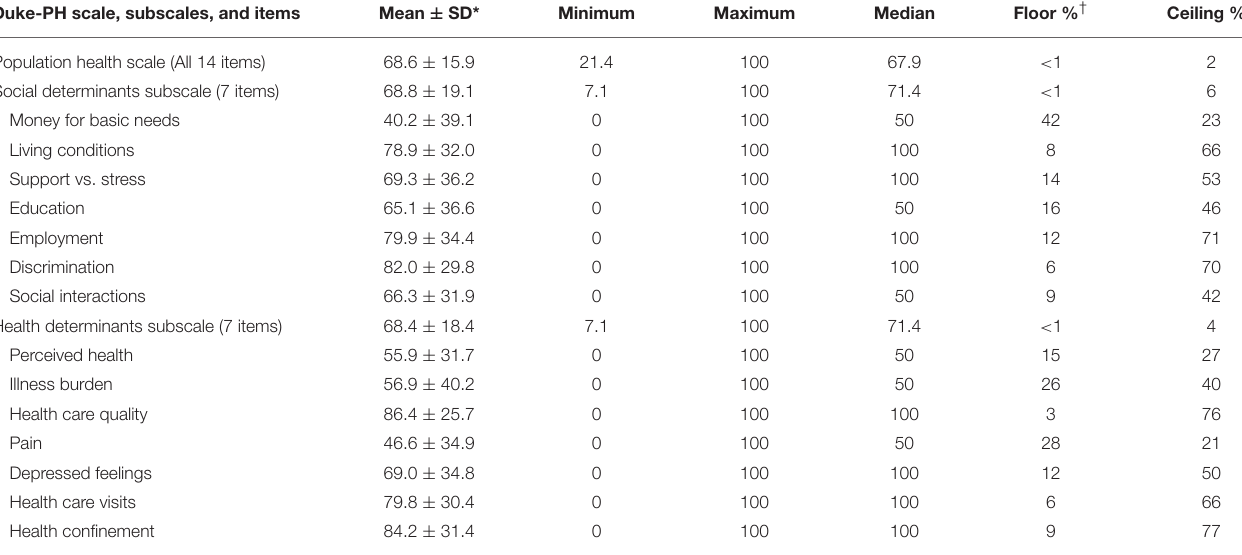
TABLE 2 | Distribution of duke-PH scale, subscale, and item scores. Duke-PH scale, subscales, and items Mean ± SD* Minimum Maximum Median Floor % † Population health scale (All 14